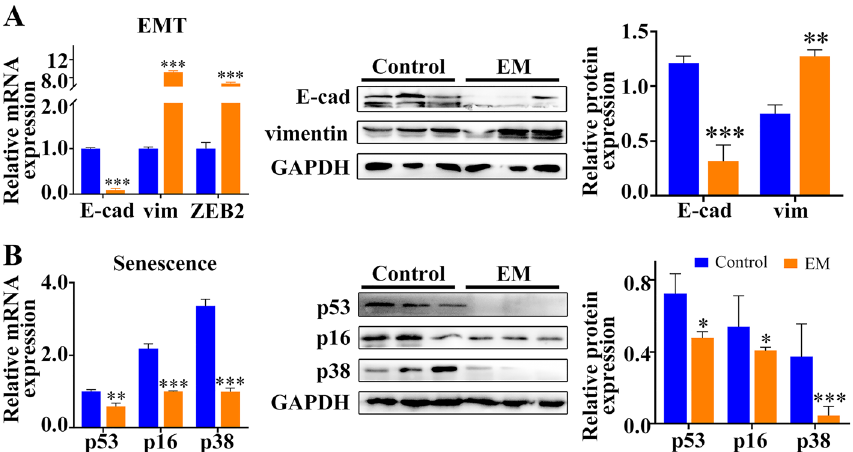
Figure 2. Relative expression of EMT- and senescence-related genes Expression as shown by qRT-PCR and western blotting, respectively ( A , B ). Anti-GAPDH antibody was used as loading control. Greyscale values of the bands were determined by Quantity One software. * p < 0.05, ** p < 0.01, *** p <